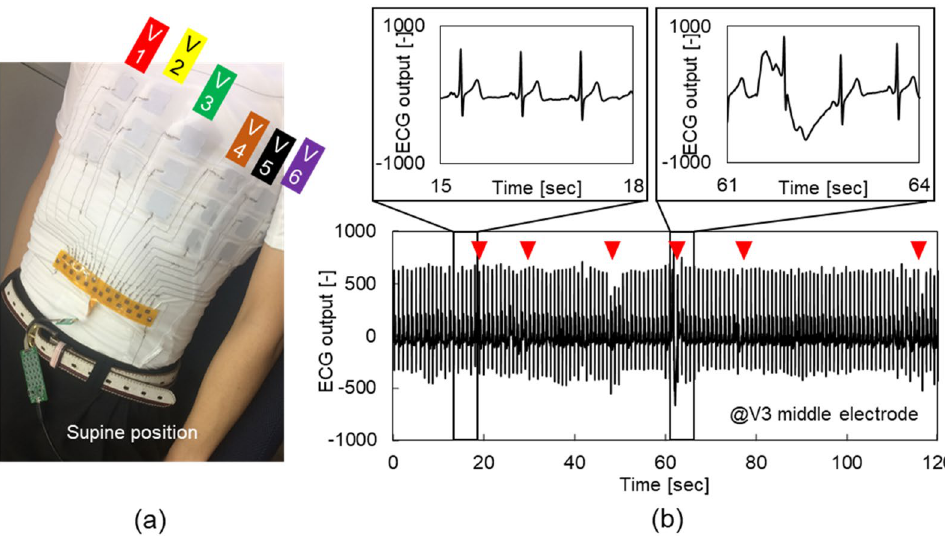
Figure 4. Experimental results of multi-lead ECG measurements. ( a ) Photograph of the experiment. The subject put on the wearable device and rested in the supine position while breathing freely. ( b ) ECG signal (from V3 position of middle electrodes) from a 2 min measurement